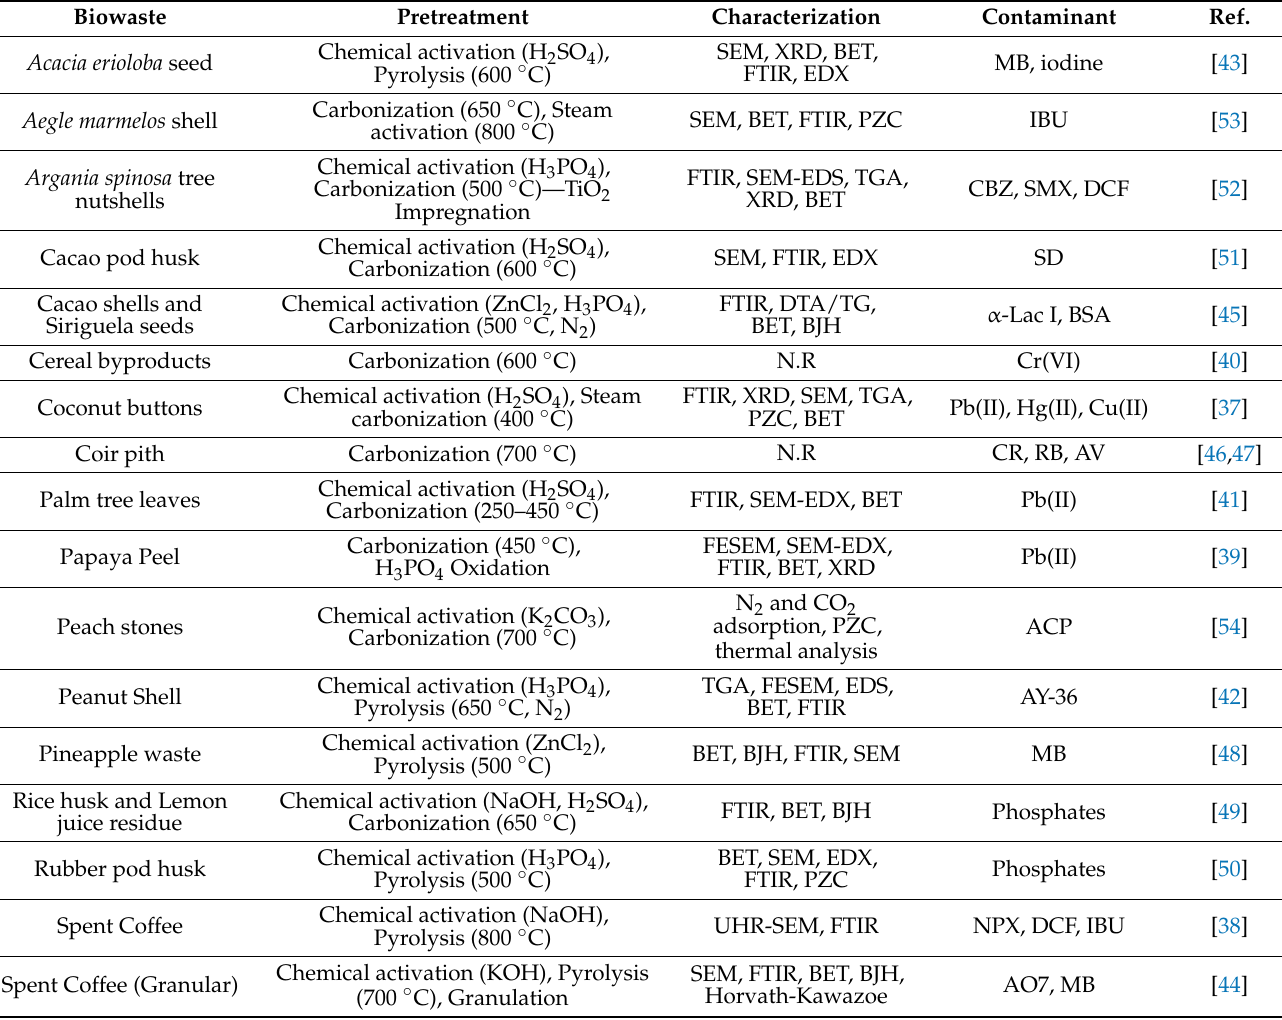
Table 1. Generation and characterization of activated carbon derived from agricultural residues (grains, seeds, fruits, vegetables, herbage, and forage) to remove heavy metals, industrial contami- nants, ions, and